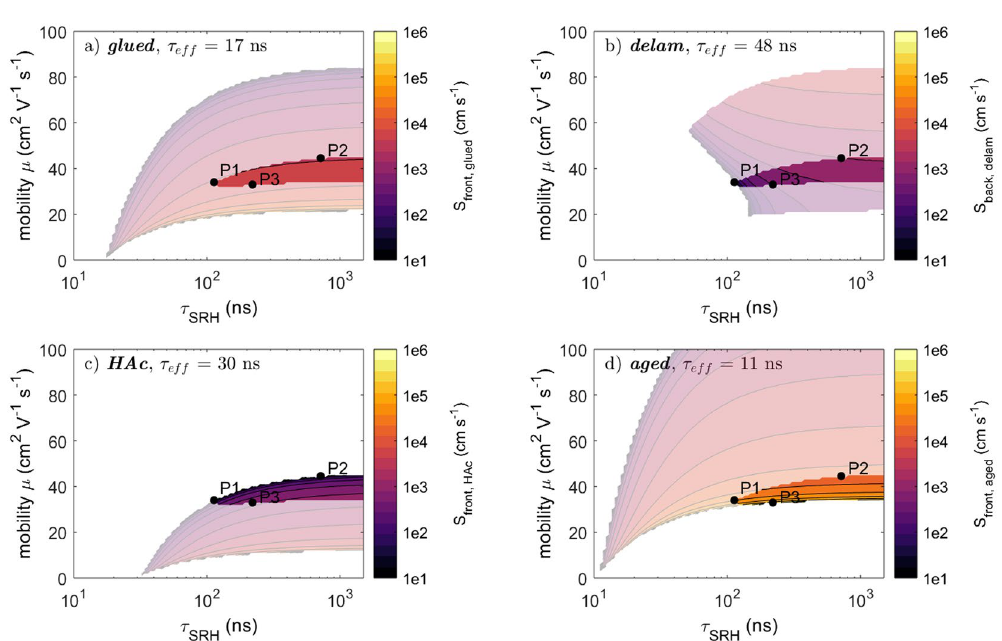
Figure 4. Estimation of the valid parameter values of τ SRH , μ and the unknown surface recombination velocity of the corresponding sample configuration according to Eqn. (14) for the CIS absorber. The pale color maps in the background indicate the parameters satisfying Eqn. (14) when only a single measurement for the indicated configuration is taken into account. The bright (and smaller) color map is the intersection of all individual color maps. These bright maps take also the restrictions for τ SRH and μ into account, which are given by the measurements of the other